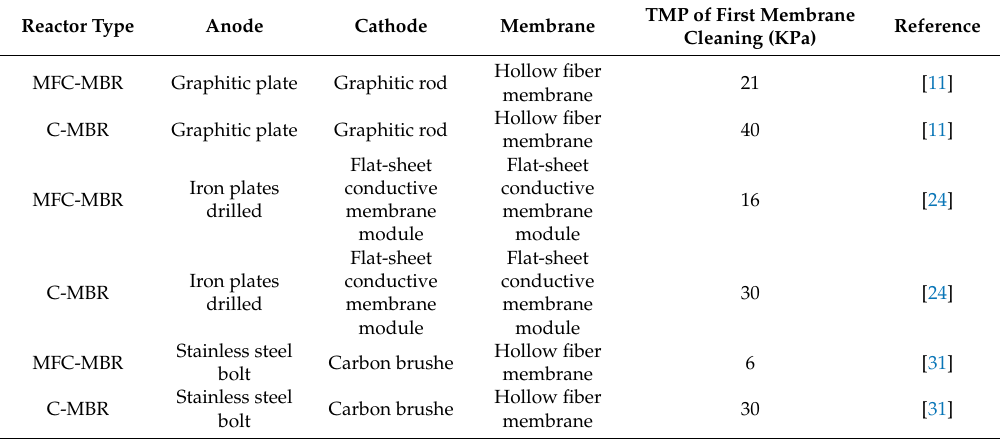
Table 3. Trans-membrane pressure (TMP) of the MFC-MBR system and